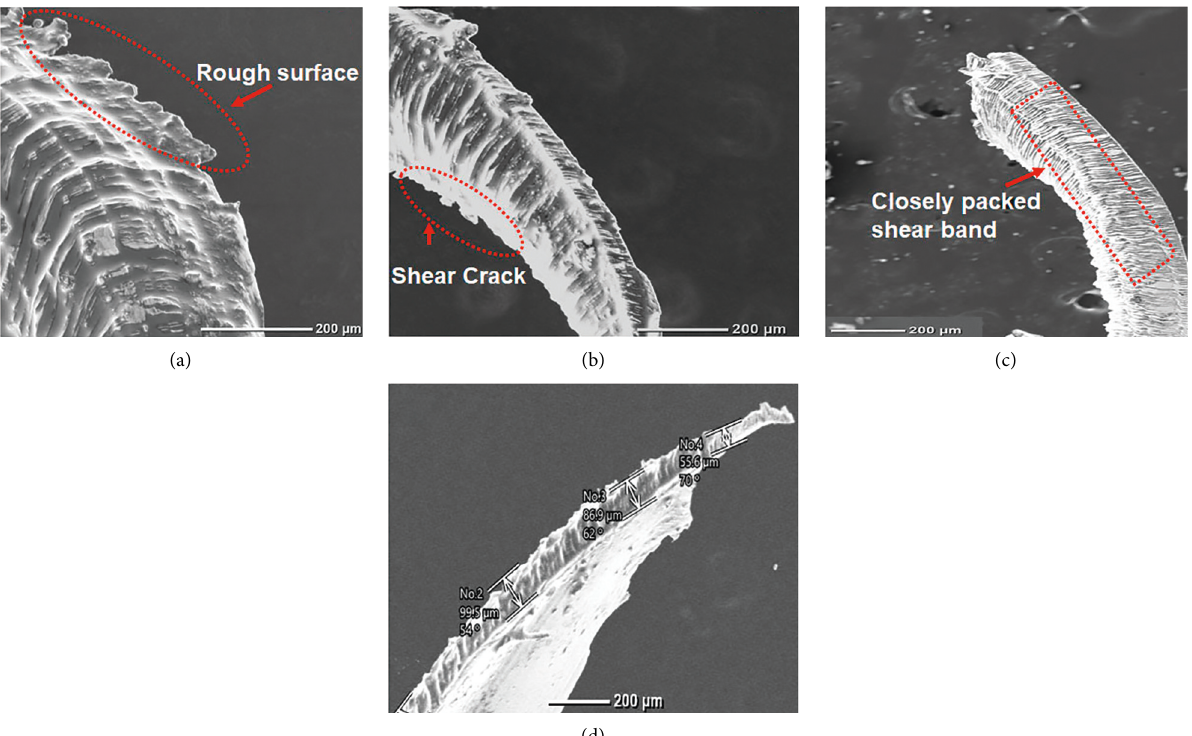
Figure 10: Chip morphology of the machined DMLS component.